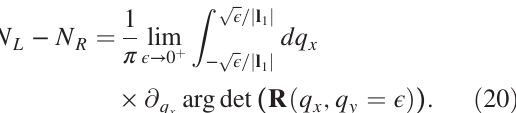
FIG. 3. The contour used to establish the relationship between the bulk structure and the locations of the zero modes. Via complex analysis, the full contour counts the difference in numbers of long-wavelength zero modes on the left and right edges while remaining insensitive to the short-wavelength modes. As described in the text, for this particular contour, the dashed portions may be neglected, such that the locations of the zero modes are determined solely by the bulk physics captured in the solid